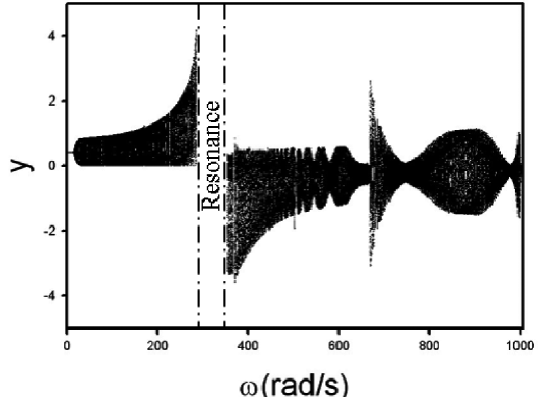
Fig. 5. The bifurcation diagram of y -displacement at the mid-span point versus rotation speed excited by electromagnetic load. D = 0.25 m, γ m = 1000 T 2 m/H, ρ s = 7800 kg/m 3 , E = 206 GPa, C = 0.001 D , C e = D /1600, L = 3 m, L b = D /4, e ¯ m = 0.0001 m, x a = 0.08, x b = 0.92, μ o = 0.001 Pa · s.